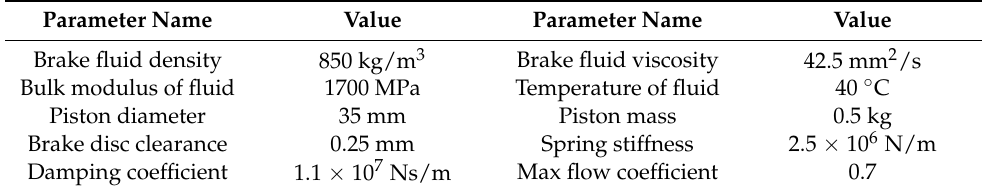
Table 2. Hydraulic system parameter specifications in the DREHB model.